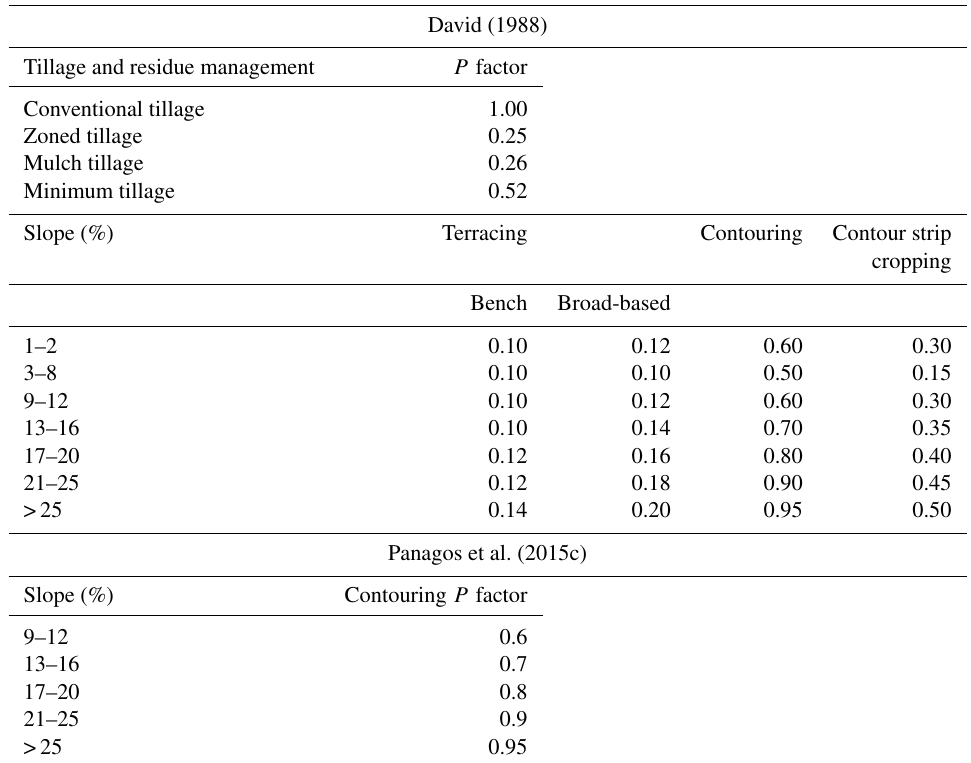
Table 11. P factors for different types of agricultural management practices.